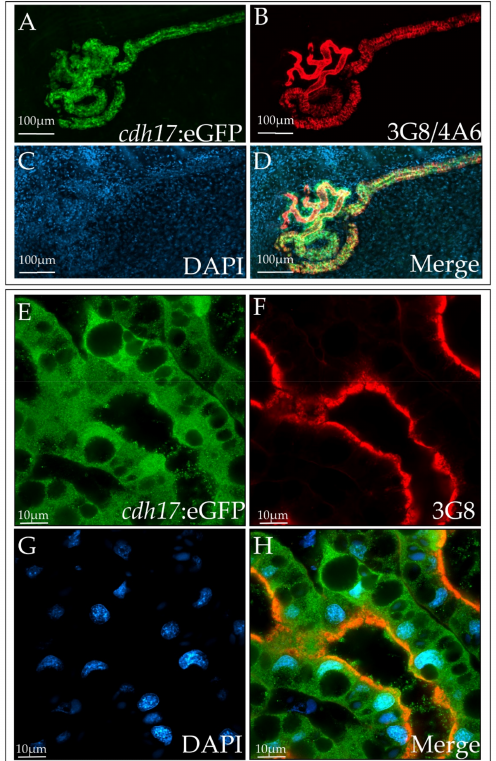
Figure 3. Subcellular GFP expression in the cdh17 :eGFP line is largely cytoplasmic and nuclear. Fixed stage 42 cdh17 :eGFP embryos were stained with ( A , E ) anti-GFP, ( B , F ) 3G8/4A6, and ( C , G ) DAPI (4 (cid:48) ,6-diamidino-2-phenylindole). ( E – H ) Magnified image of proximal